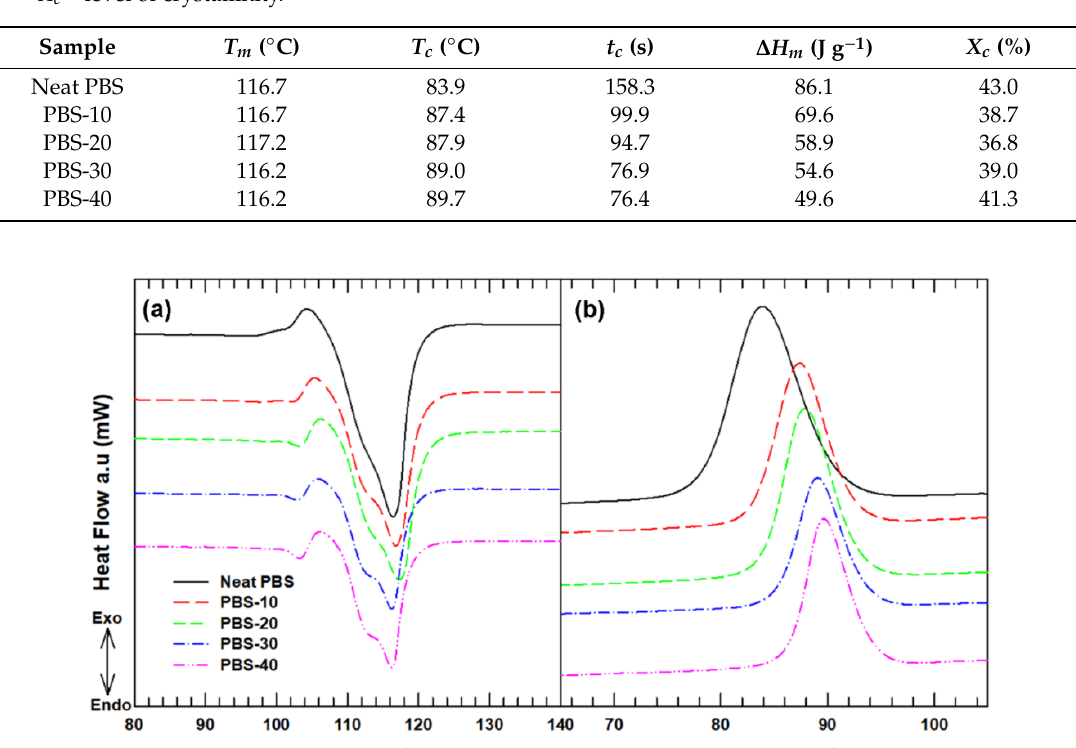
Thermal behavior of the neat PBS and its composites.